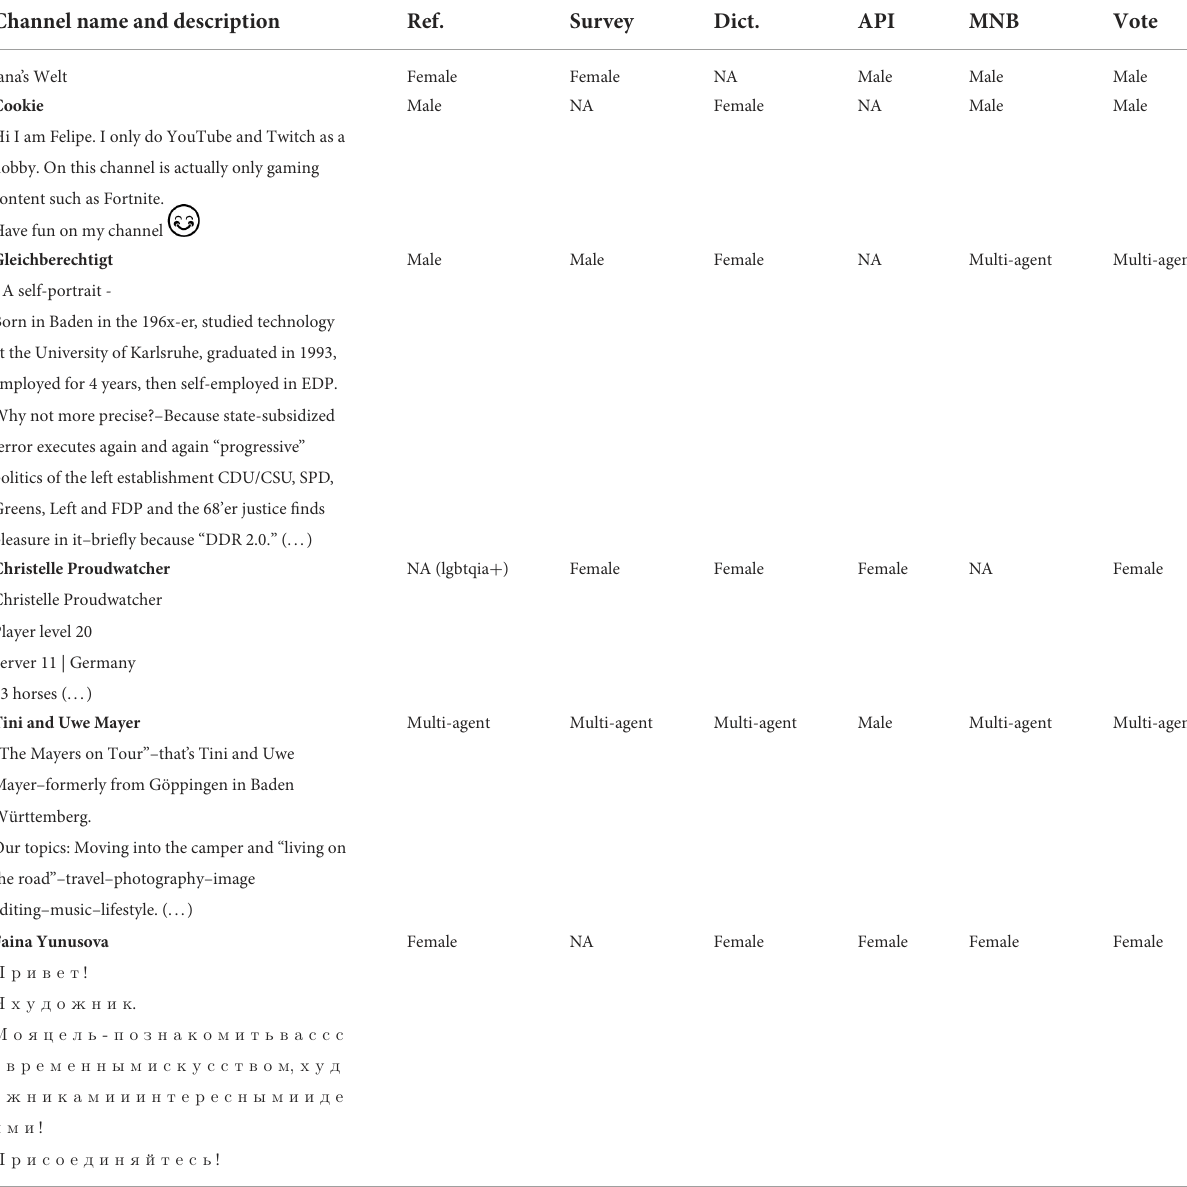
TABLE 3 Exemplary results of different classification methods. Channel name and